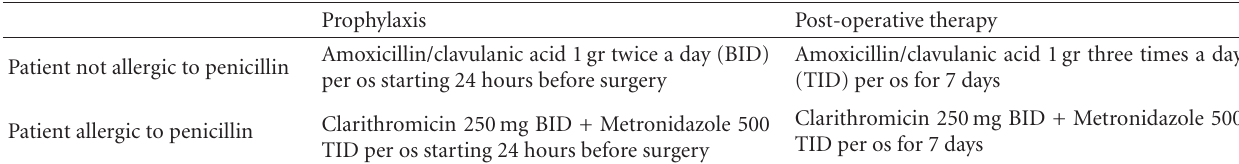
Table 1: Prophylaxis and post-operative drug therapy in sinus lift patient.